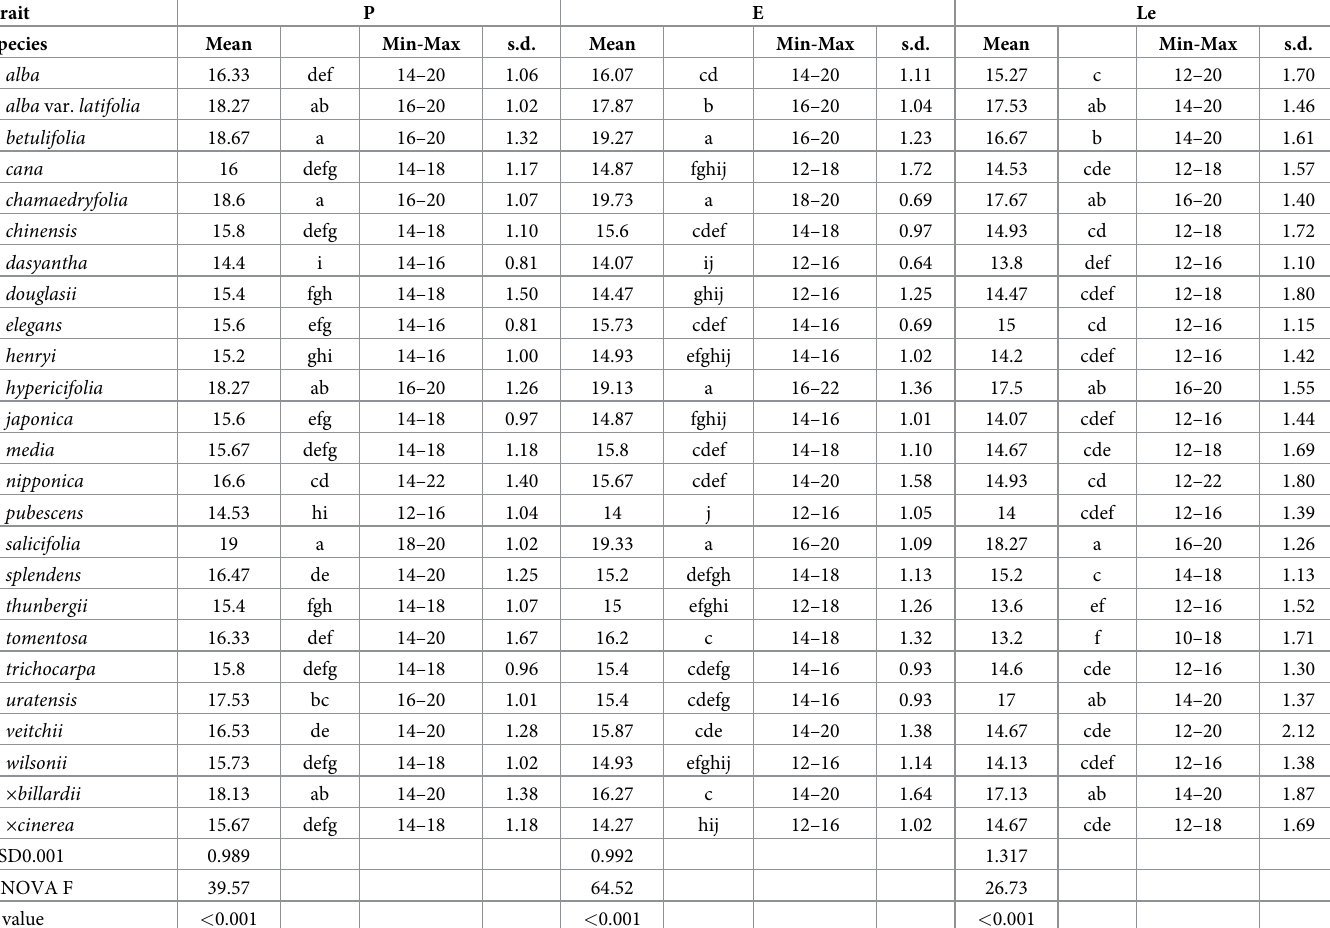
Table 3. Minimal, maximal and mean values as well as coefficients of variation (CV) for length of polar axis (P), equatorial diameter (E) and length of ectoaperture (Le) in studied taxa. Trait